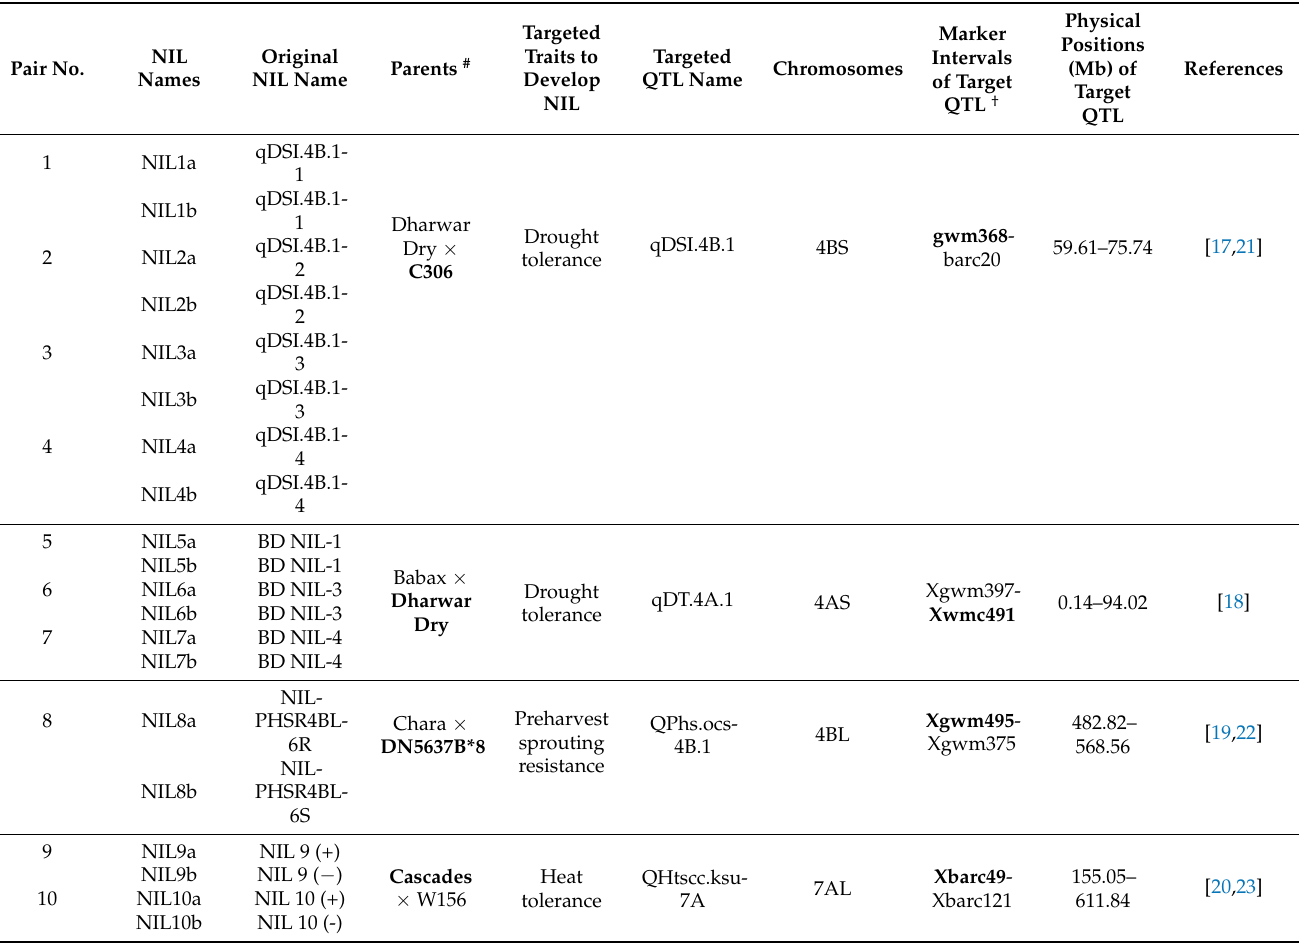
# Bold indicates donor parent of the positive allele of respective quantitative trait loci (QTL). † Bold indicates screening marker used for developing the